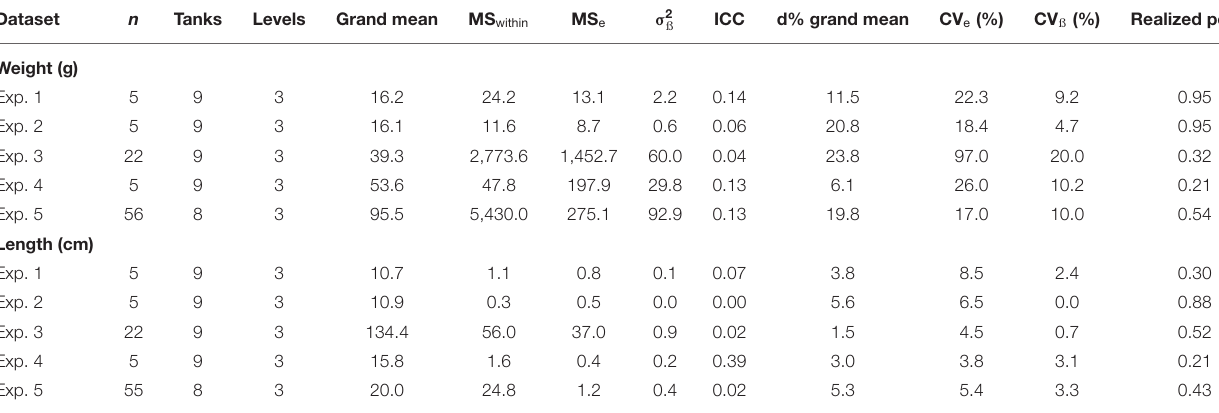
TABLE 1 | Fish morphological traits variation analysis for each experimental trial.